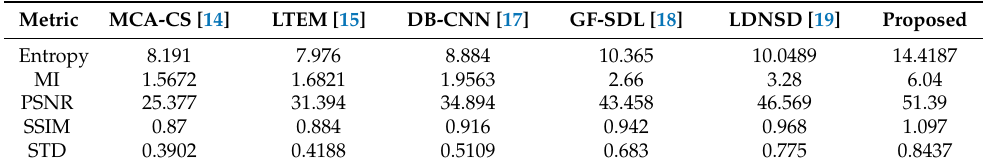
Table 7. MR-PET image fusion approaches performance analysis.